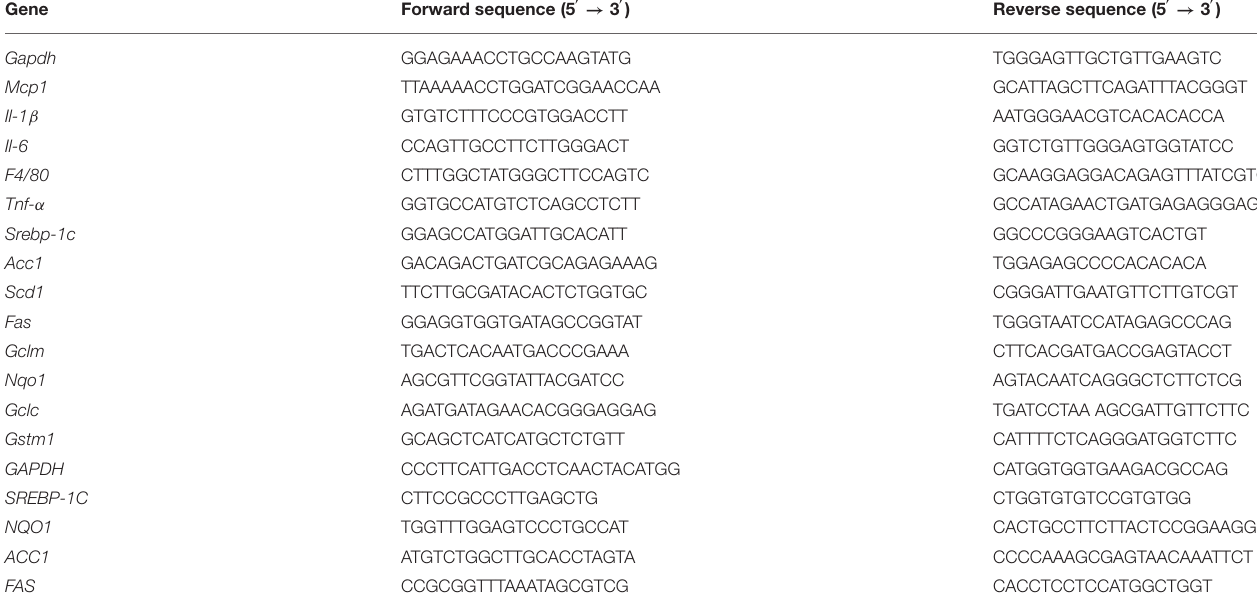
TABLE 1 | Primer sequences used in RT-qPCR. Gene Forward sequence (5 ′ → 3 ′ ) Reverse sequence (5 ′ → 3 ′